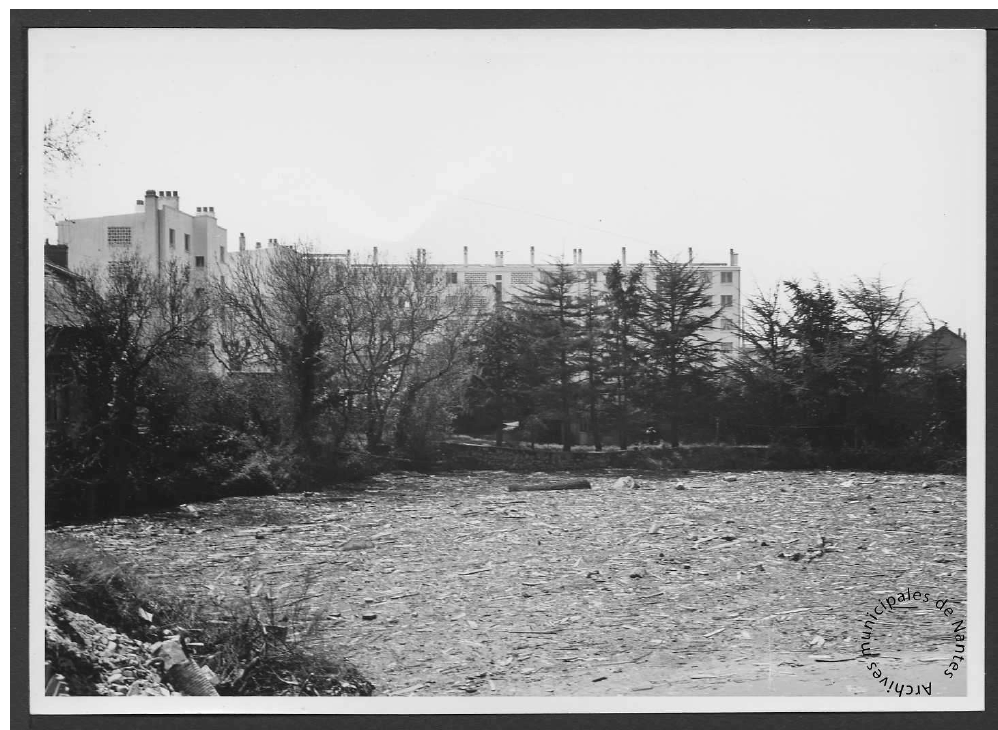
Figure 2. La Fournilli`ere in the early seventies. Source: City Archives of